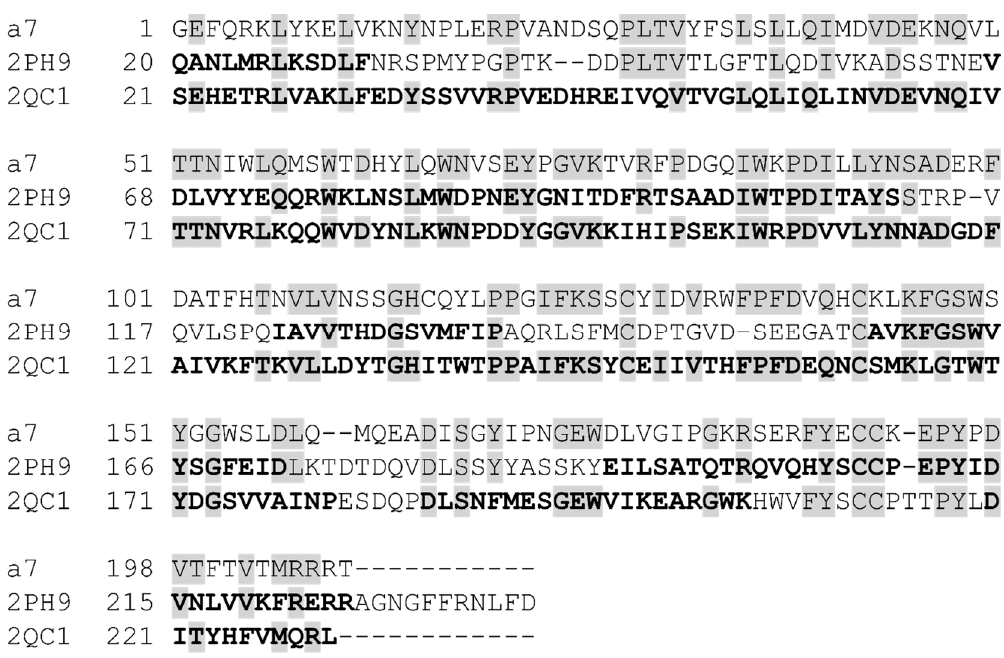
Figure 5. Sequence alignment. Sequence of the human α 7 nAChR and templates, AChBP co- crystalized with galantamine (PDB ID: 2PH9), and rat α 1 subunit (PDB ID: 2QC1) were aligned using T-Coffee and used to build the homology model. Residues from both templates used in homology modelling are shown in bold. Conserved residues are marked with grey boxes. The sequence identities counting only the parts of the templates that were used for modelling constitute 30 and 39%, respectively, for 2PH9 and 2QC1. For the human α 7 nAChR, the sequence was used without the signal peptide.